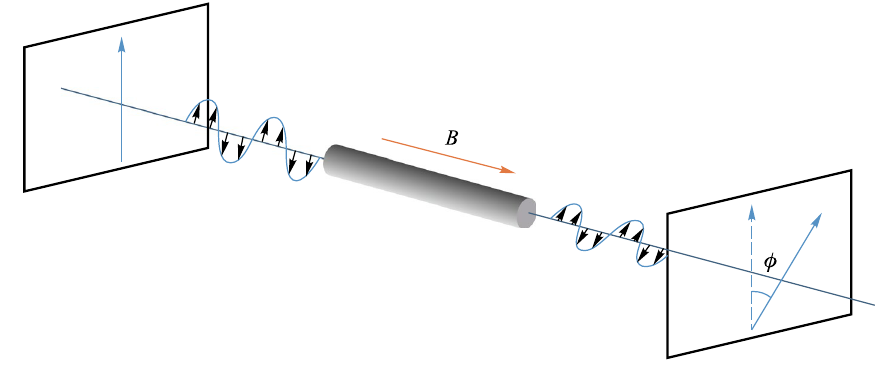
Fig. 16 Principle of Faraday magneto-optical effect